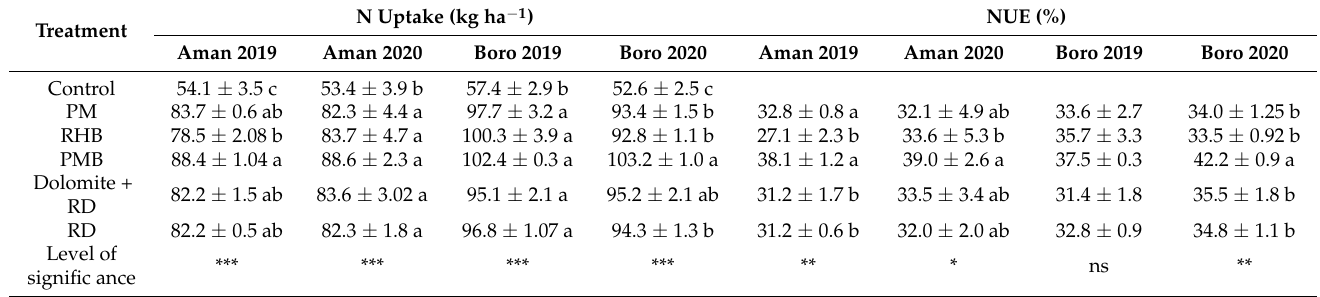
Table 6. Effects of different treatments on nitrogen uptake and NUE in acidic